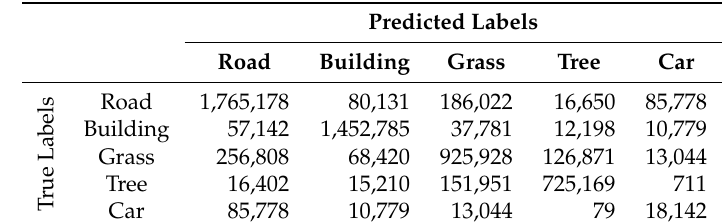
Table 7. Confusion matrix obtained for classified mean-shift segmentation based on a before-segmentation fusion (Figure 9c).